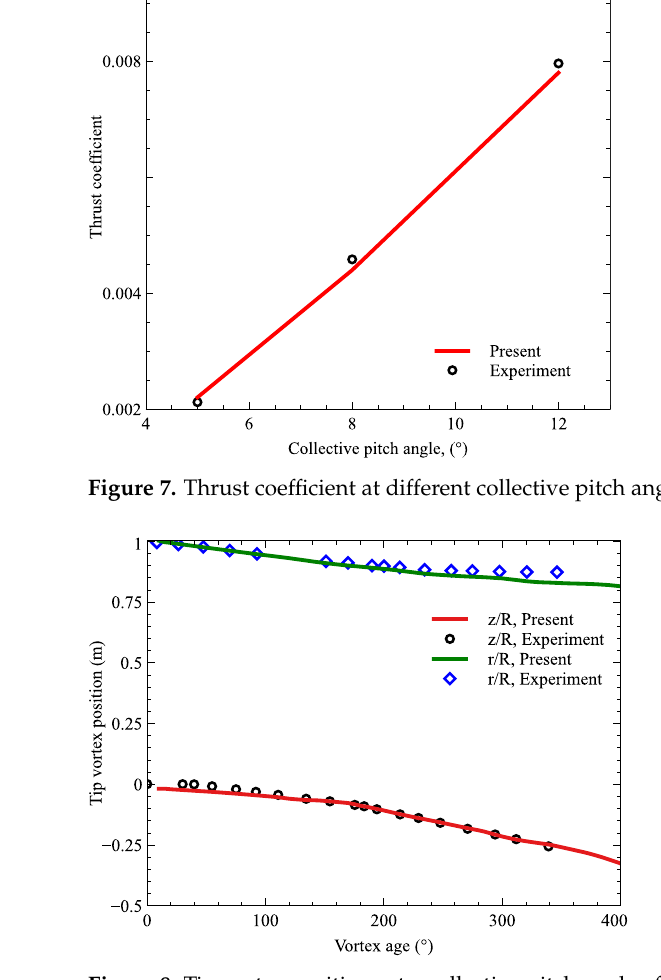
Figure 8. Tip vortex positions at a collective pitch angle of 8 ◦ .